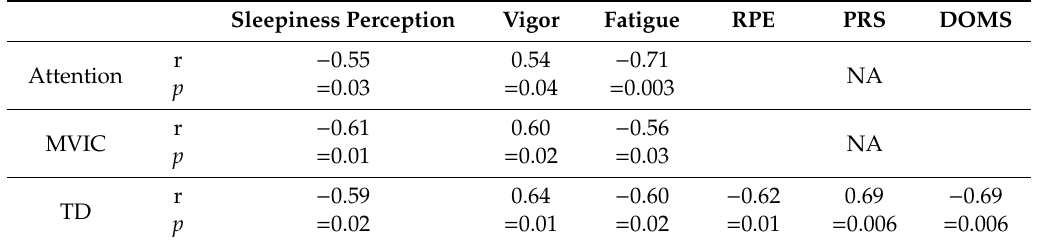
Table 7. Correlations between selected parameters for changes between N90 and N40. Sleepiness Perception